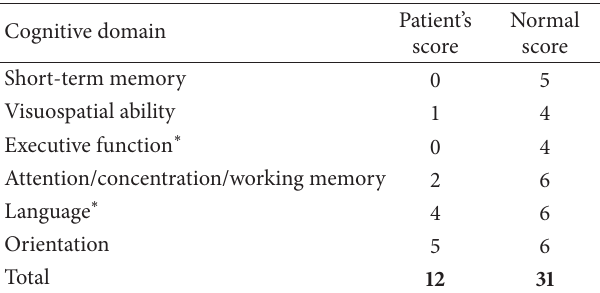
Figure 1: Axial MRI of the brain. Diffusion weighted imaging sequence showing acute left globus pallidus infarct. Table 1: Montreal Cognitive Assessment cognitive domains (derived from [7]).